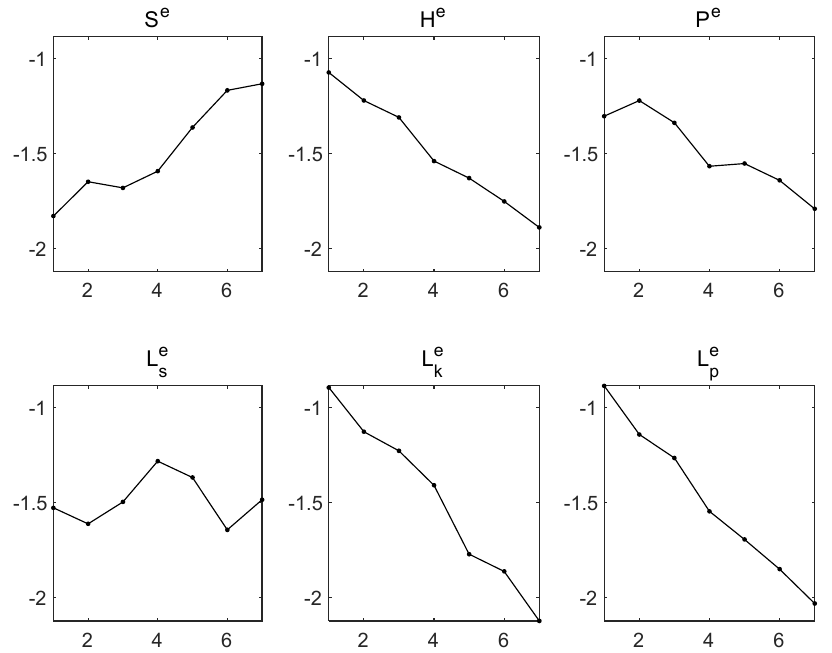
Figure 8. Trend diagram of insertion loss | S 21 | for electromechanical coupling identification parameters of flexible interconnection.